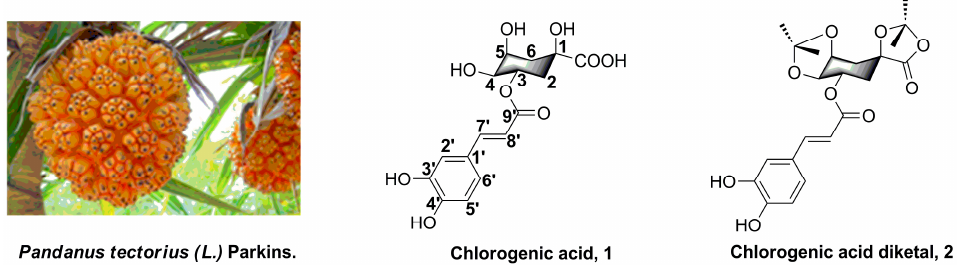
Figure 1. The plant Pandanus tectorius (L.) Parkins. and the structures of chlorogenic acid ( 1 ) and its analogues Chlorogenic acid diketal ( 2 ).